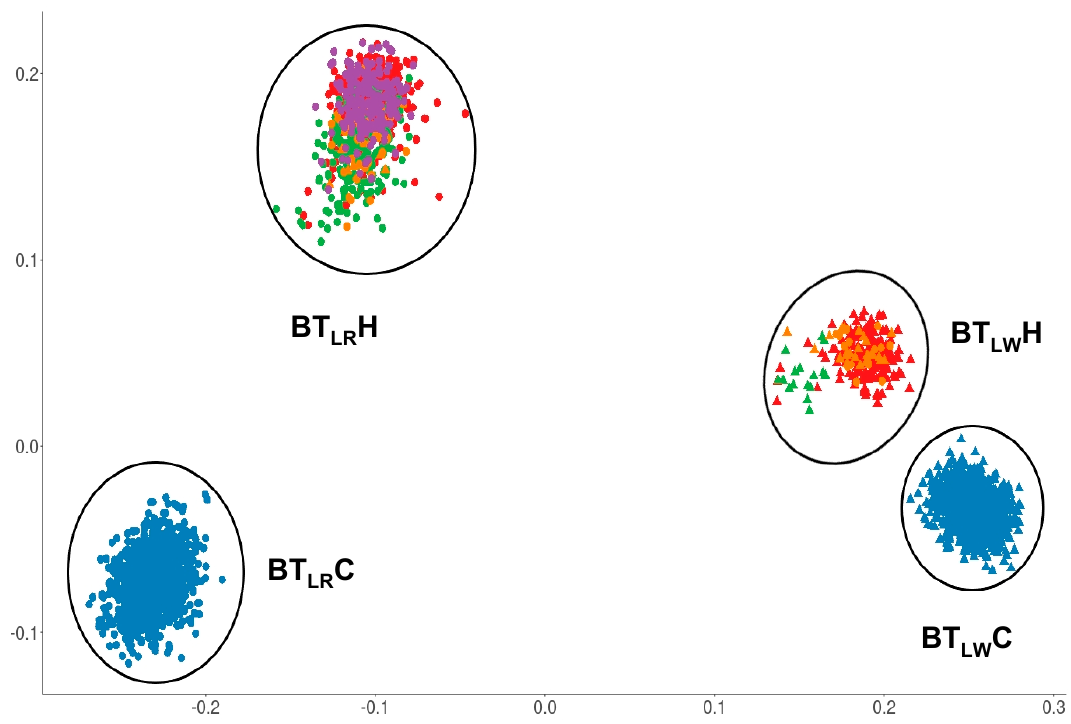
Figure 2. Distribution of animals in clusters based on genetic relationship matrix, BT LR C n = 1293, BT LW C n = 1317, BT LW H n = 256, BT LR H n = 735. Colors are representing the different organizations. Filled-in circles are representing Landrace animals, filled-in triangles are representing Large White animals.